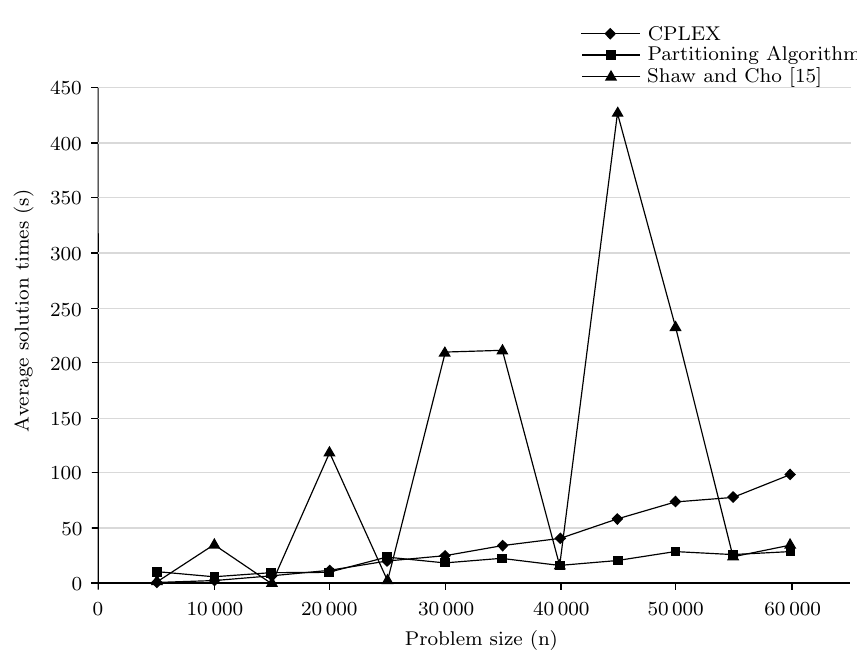
Figure 2: Average solution times for the weakly correlated TKP data